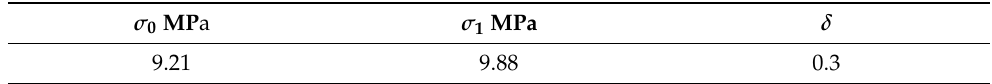
Table 3. Material parameters in Equation